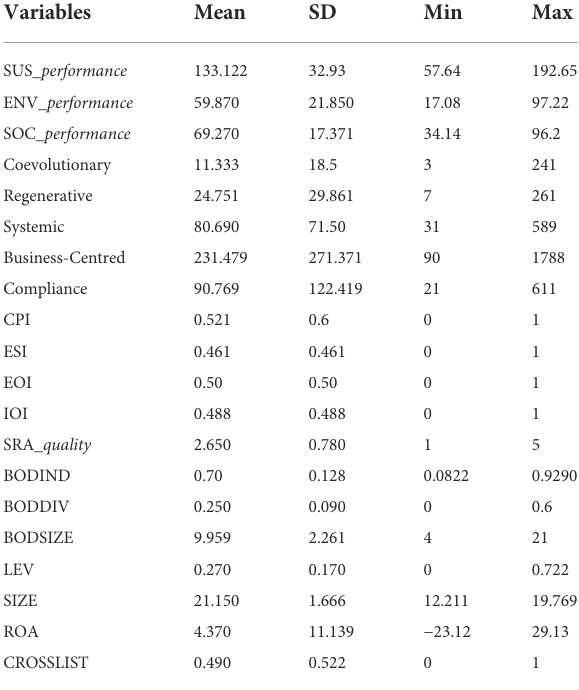
TABLE 1 Summary